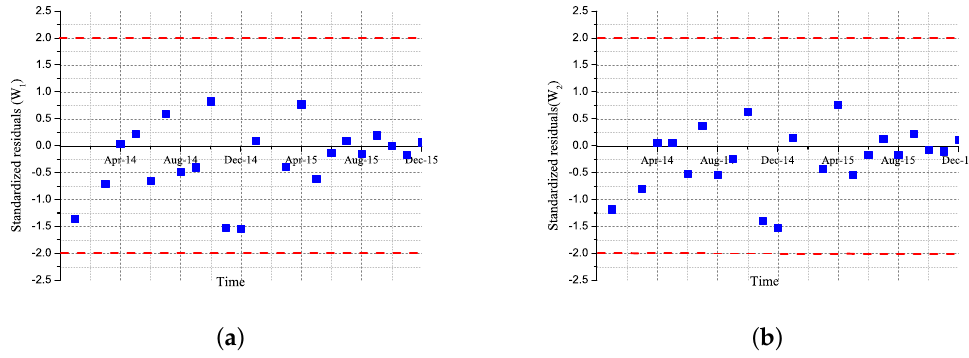
Figure 1. ( a ) The standardized residual of W 1 ; ( b ) The standardized residual of W 2 .